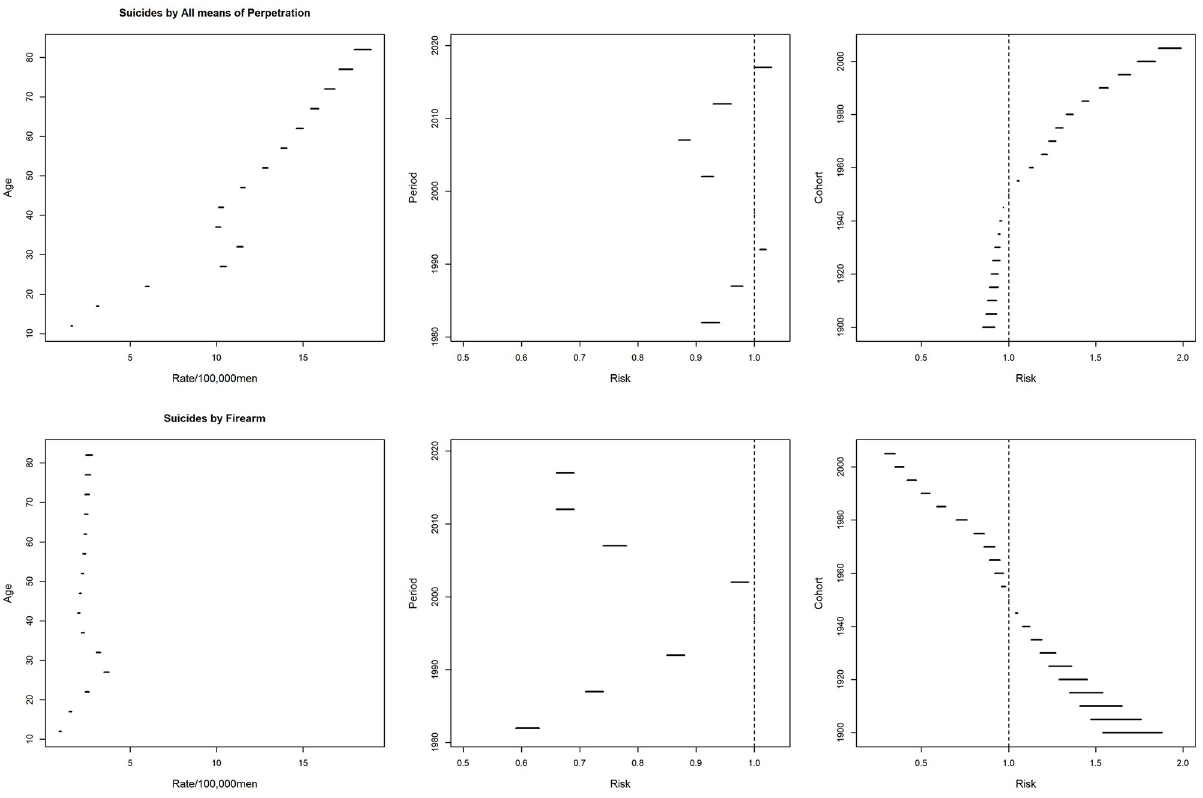
Fig 5. Age, period, and cohort effects estimated by estimable functions for total and firearm-related suicides, in Brazil, from 1980 to 2019.